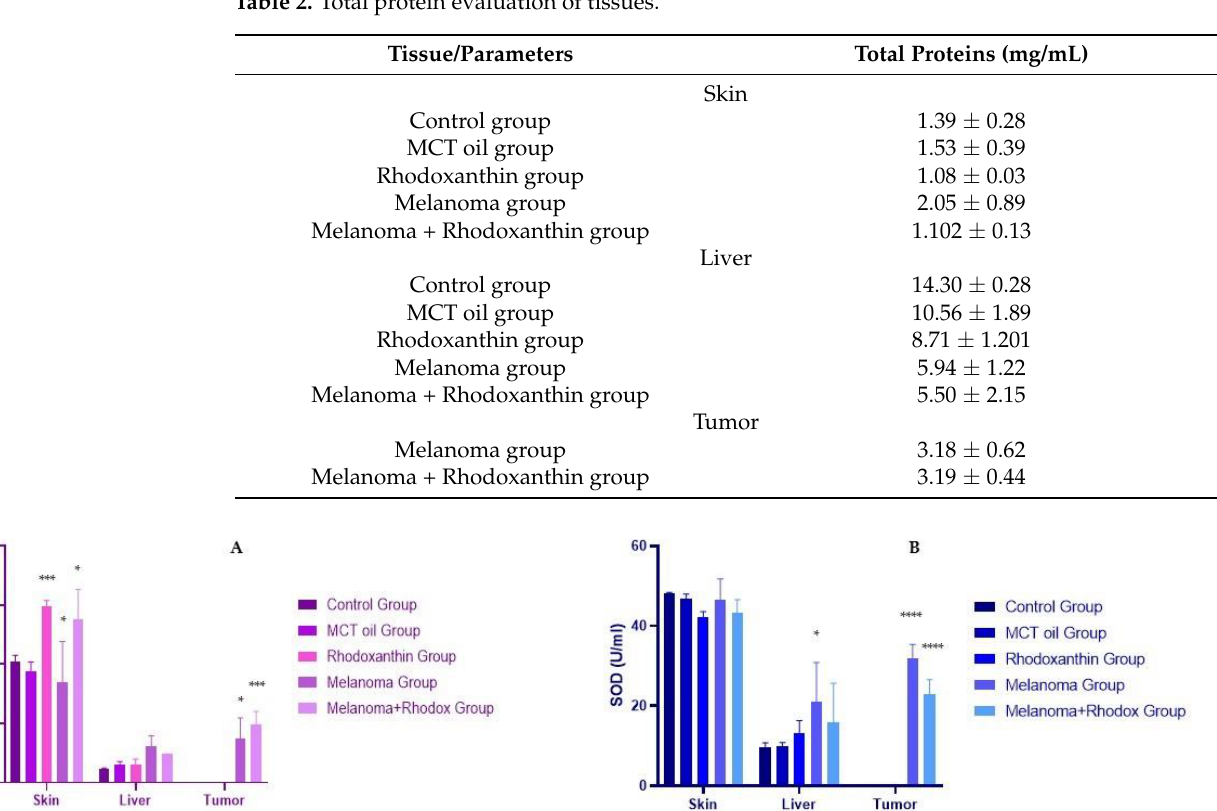
Figure 7. Enzymatic antioxidant activity of glutathione-peroxidase ( A ) and the total antioxidant sta- tus ( B ) in tissues. Values are expressed as mean ± standard deviation SD from three independent experiments. Statistical significance level * p < 0.05, ** p < 0.01, and **** p < 0.0001. At the skin tissue level, we noticed an increase in catalase activity in the rhodoxanthin group compared to the value determined in the control group ( p < 0.05). In addition, the melanoma + rhodoxanthin group had a higher catalase value than the control group and the melanoma group (1381.91 ± 250.06 vs. 1025.11 ± 50.14, p < 0.05; 1381.91 ± 250.06 vs. 846.23 ± 345.21, p < 0.05). In the same tissue, the SOD value did not differ significantly between groups, with a minor decrease in all other groups compared to the control group, with the melanoma + rhodoxanthin group having the lowest representative value. Furthermore, the glutathione-peroxidase value decreased in the rhodoxanthin, mel- anoma, and melanoma + rhodoxanthin groups, with the melanoma + rhodoxanthin group having the lowest value (melanoma vs. control, p < 0.05). The TAS value showed the fol- lowing variations: a drop in the melanoma group vs. the control group ( p < 0.05), a minor decrease in the melanoma + rhodoxanthin group vs. the control group ( p < 0.05), and an increase in the melanoma + rhodoxanthin group vs. the melanoma group ( p > 0.05). Significant changes in catalase were found in liver tissue, with an increase in activity in all groups compared to the control group (melanoma vs. control, p < 0.05). SOD activity at the liver level was also significantly increased in the rhodoxanthin, melanoma, and mel- anoma + rhodoxanthin groups. Similar information was gathered for the GPx value. The variance of the TAS values was slightly different, with the melanoma group registering